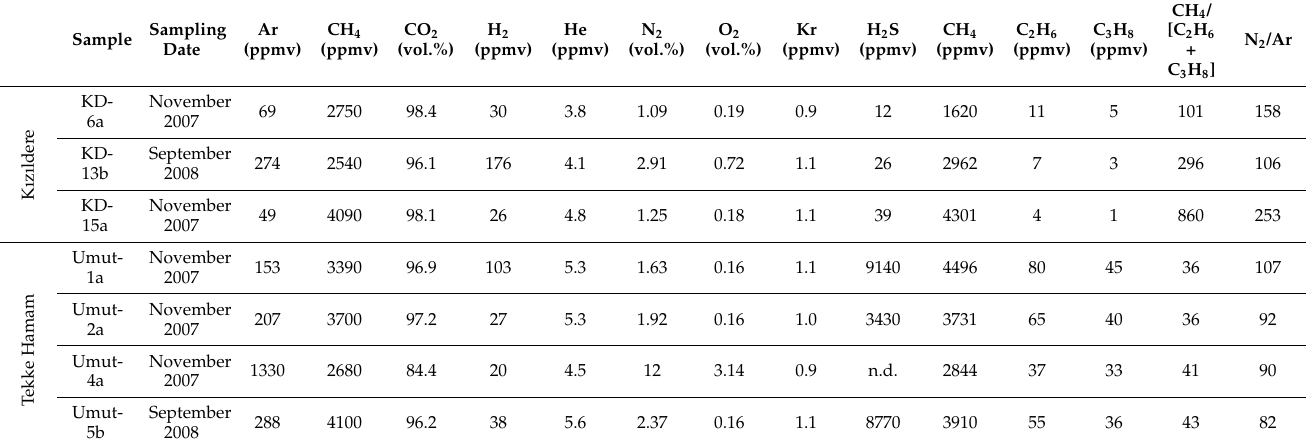
Table 1. Chemical compositions of gas samples from Kızıldere and Tekke Hamam geothermal fields.